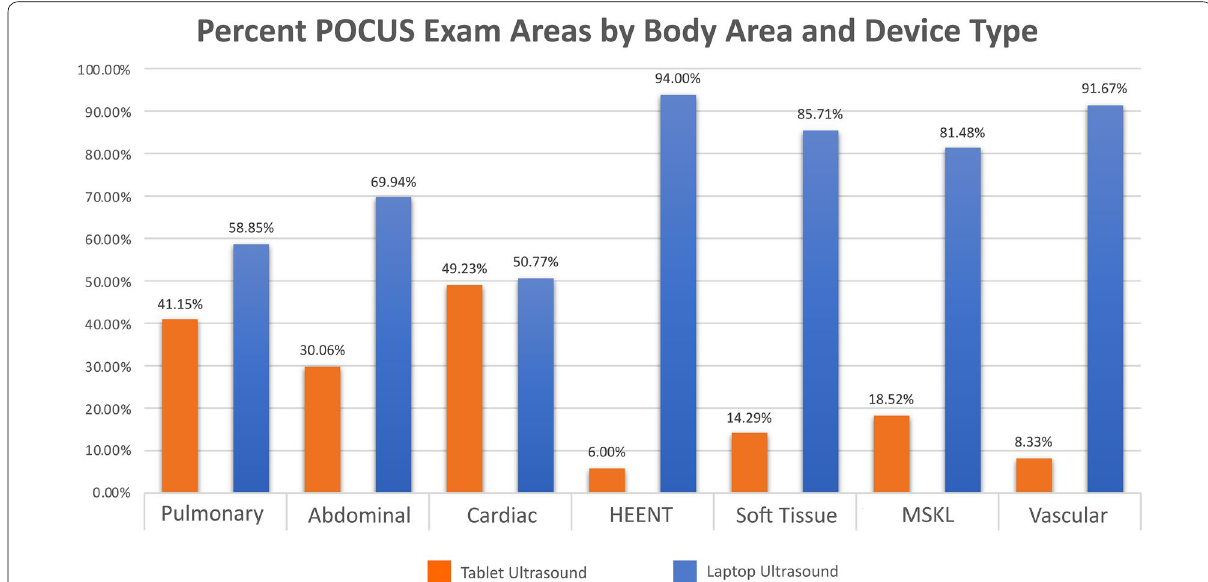
Fig. 3 Percent of POCUS exam areas ( n 2901) performed grouped by body area and ultrasound device type (tablet vs. laptop) from September = 2017 through May 2019. HEENT head, eyes, ears, nose, throat; MSKL = =